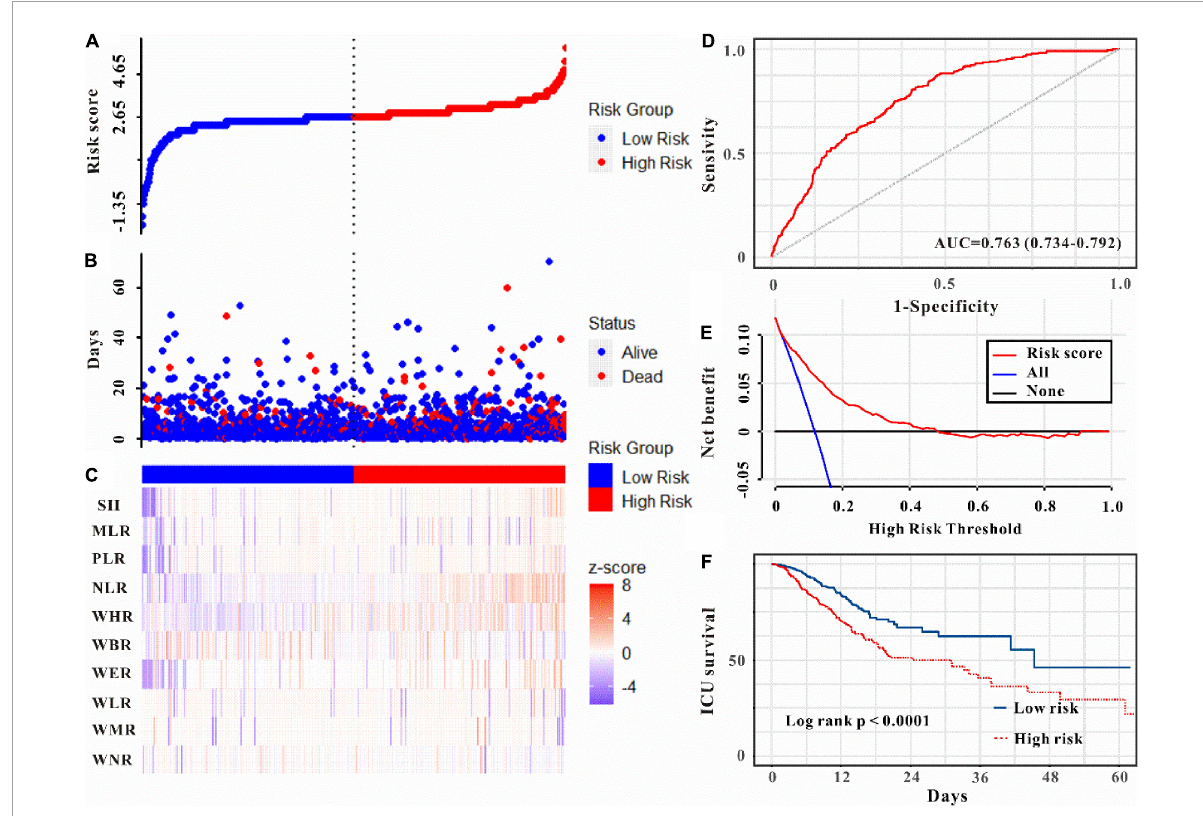
FIGURE5 Risk score was established to detect the ICU mortality of critically ill patients with IS. All patients were distinguished into high and low risk based on the risk score (A) , the relationship between survival time and prognosis of patients in the two corresponding groups (B) , and the heatmap of WBC-related indicators between the two groups (C) . Receiver operating characteristic (ROC) curve analysis of the risk score for ICU mortality (D) , decision curve analysis of the risk score for ICU mortality (E) . Kaplan–Meier curves show the ICU mortality of groups with different risks (F)